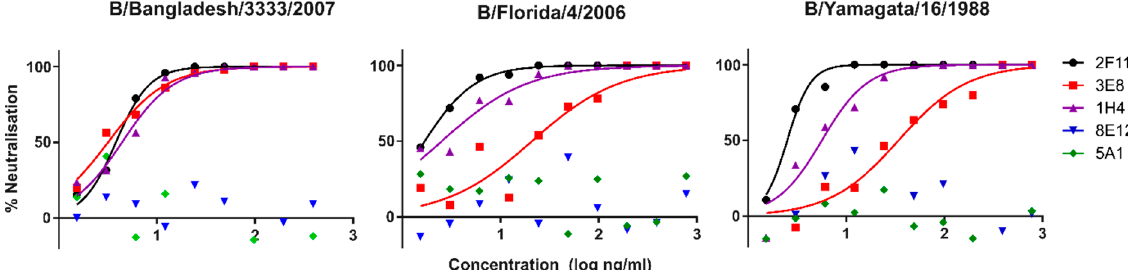
Figure 4. pMN neutralisation curves for FDA mAbs 2F11, 3E8, 1H4, 8E12 and 5A1 against PV bearing HA glycoproteins from Yamagata lineage strains B/Yamagata/16/1988, B/Florida/4/2006 and B/Bangladesh/3333/2007. Potent neutralisation by Yamagata specific mAbs 3E8 and 1H4, and by cross-lineage mAb 2F11. No neutralisation is observed for Victoria lineage-specific mAbs 8E12 and 5A1.